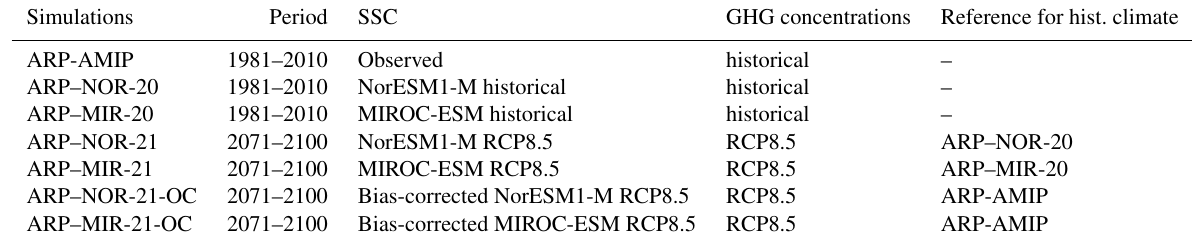
Table 1. Summary of the period, sea surface conditions, greenhouse gas (GHG) concentration and reference historical simulation (for climate projections) for each ARPEGE simulation presented in this